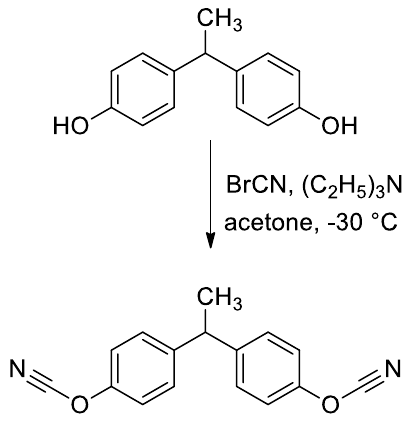
Figure 1. Scheme of synthesis of target cyanate ester.